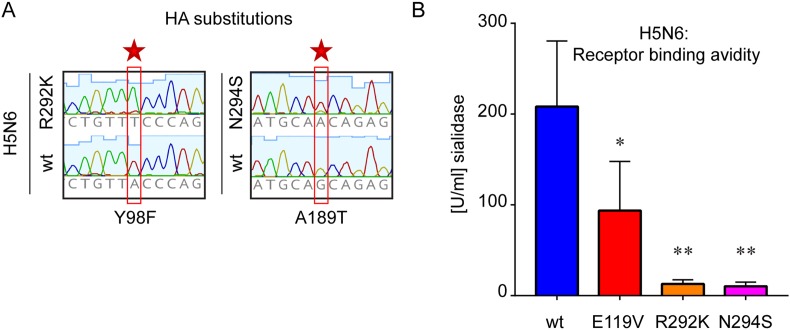
Concurrent changes in HA of NAI-resistant H5N6 viruses and their impact on receptor binding avidity. (A) Amino acid substitutions found in HA genes of H5N6_R292K and N294S viruses. HA segments were amplified from viral RNA and analysed following Sanger sequencing. Changes on nucleotide level are indicated with a red frame and a star; amino acid substitutions are shown below (H3 numbering). (B) Receptor binding avidity of H5N6 viruses. Relative receptor binding avidity was determined with 4 HAU of each virus on partially desialylated cRBCs pre-treated with recombinant NA from C. perfringens. The Y-axis shows mean ± SD of maximal NA concentration allowing for full haemagglutination of each virus (U/ml); n = 3 (*p < 0.05; **p < 0.01).